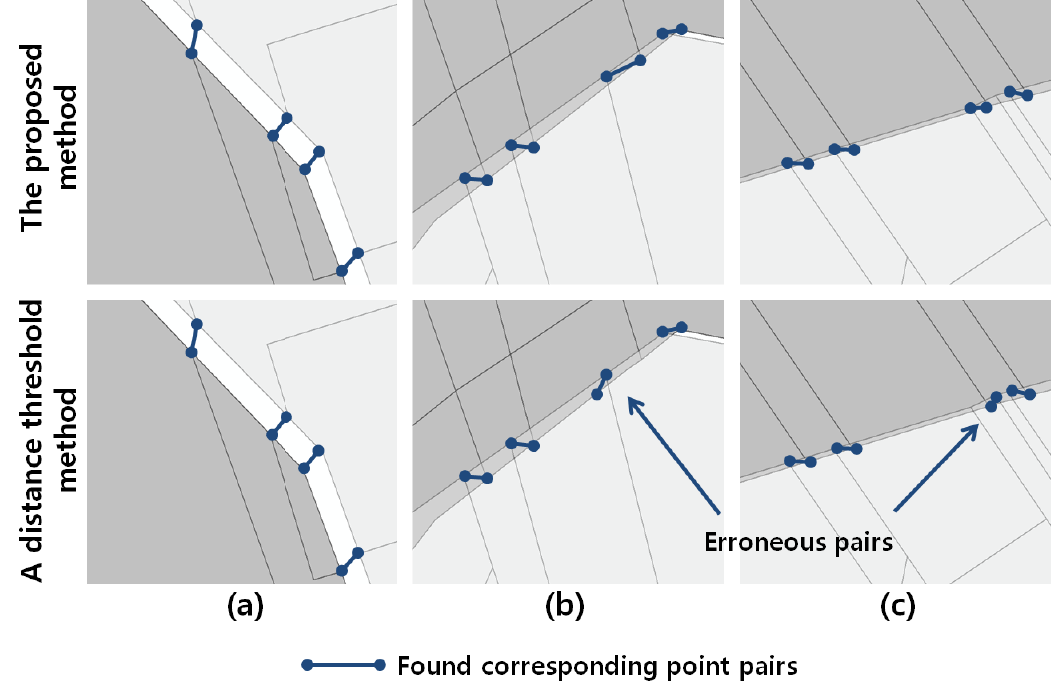
Figure 12. Comparison of corresponding point pairs found by the proposed method and the distance threshold method; ( a ) both methods find correct pairs, ( b,c ) the proposed method finds correct pairs of disconnected line segments between two maps meanwhile the distance threshold methods finds erroneous pairs.